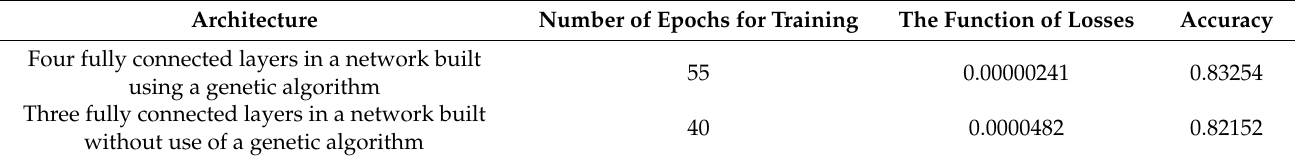
Table 5. Comparative characteristics of neural network architectures for building a general neural network.